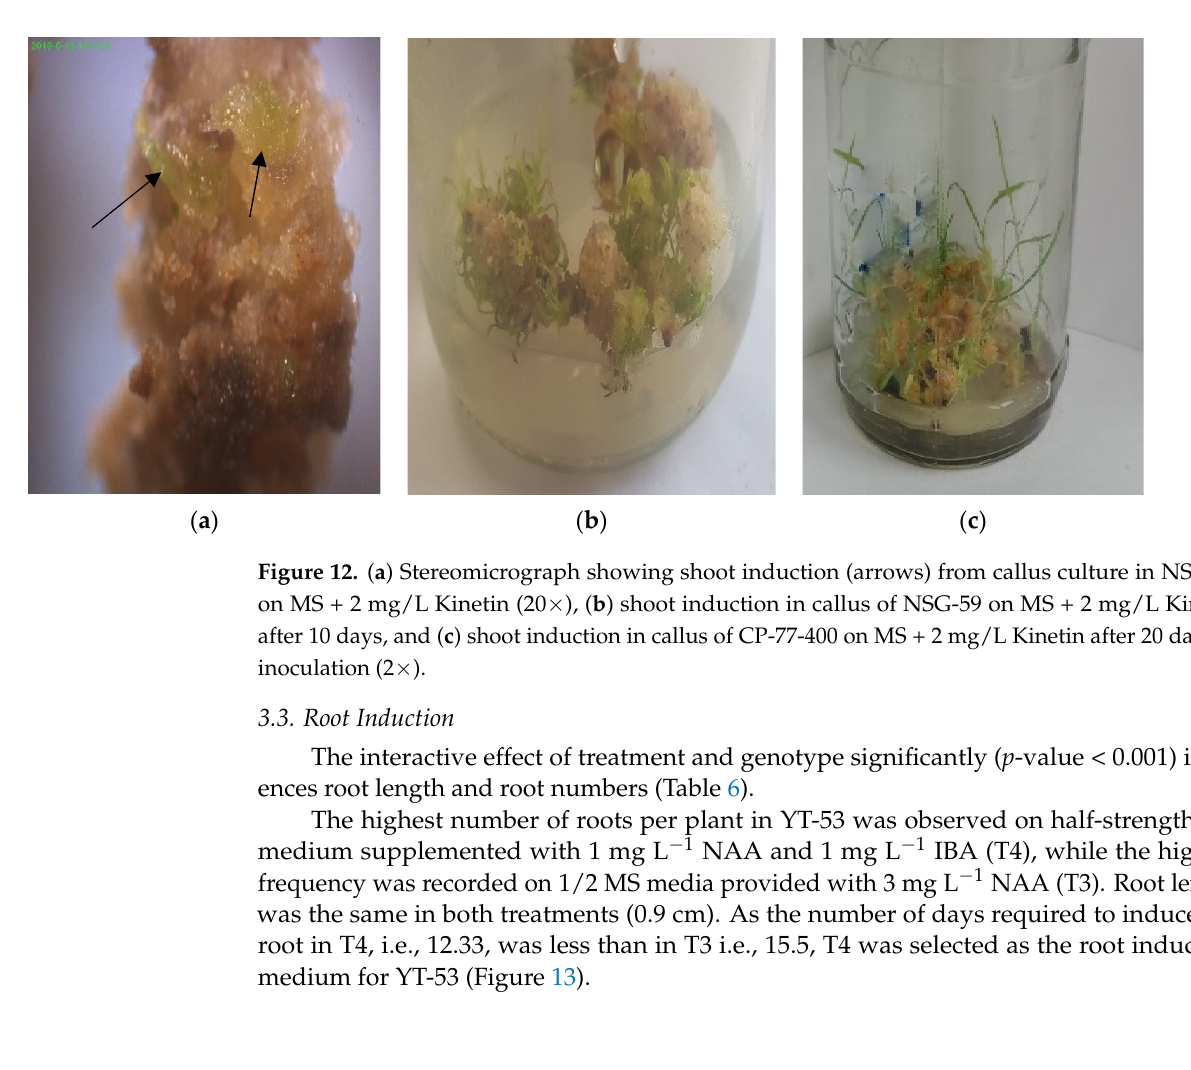
Figure 11. Effect of different media compositions on shoot induction in terms of shoot length (cm), number of shoots, frequency, and number of days in NSG-59.